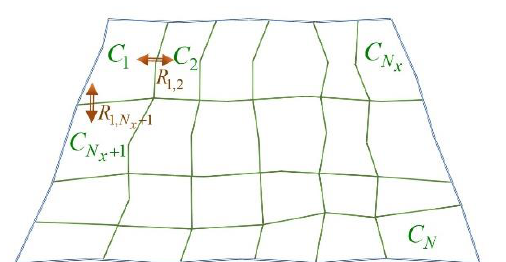
Figure 2. Arrangement of the generalized variables. The double-line, red arrows symbolize conductive (heat) transport through the resistances R ij . The blue line symbolizes thermal isolation at the boundaries of the system. We emphasize that, although topologically the grid should be rectangular to keep the explicit nature of the OEH-type methods, the geometrical shape of the cells is not necessarily rectangular.